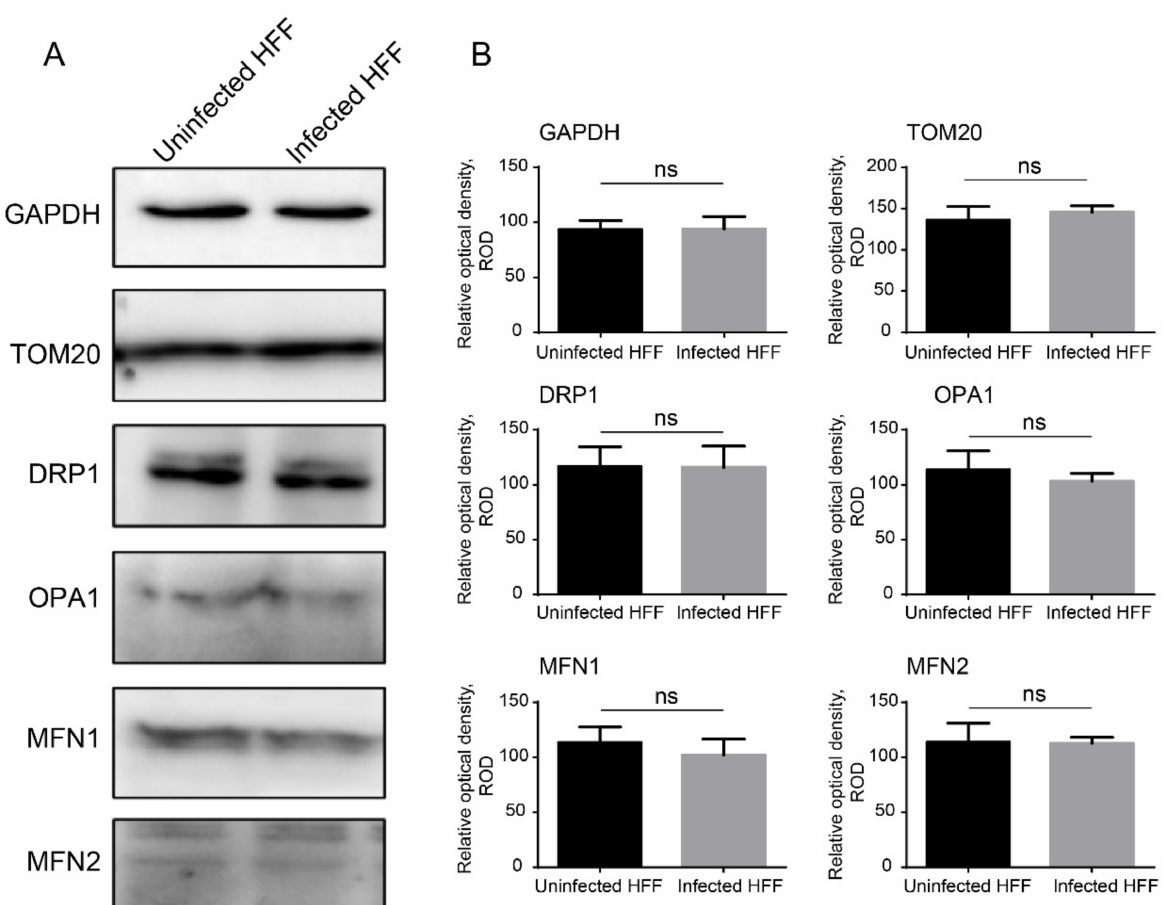
Figure 4. Characterization of DRP1 expression in host cells at 48 hpi. ( A ) E. hellem -infected HFF cells were analyzed by Western blotting to determine the regulators involved in mitochondrial dynamics, including DRP1, OPA1, MFN1, MFN2, and TOM20. GAPDH was used as an internal control. DRP1, dynamin 1-like protein; OPA1, optic atrophy 1; MFN1, mitofusin 1; MFN2, mitofusin 2; TOM20, translocase of the outer membrane of mitochondria 20; GAPDH, glyceraldehyde-3- phosphate dehydrogenase. ( B ) Statistical analysis of the relative optical density of Western blot bands. ns, not